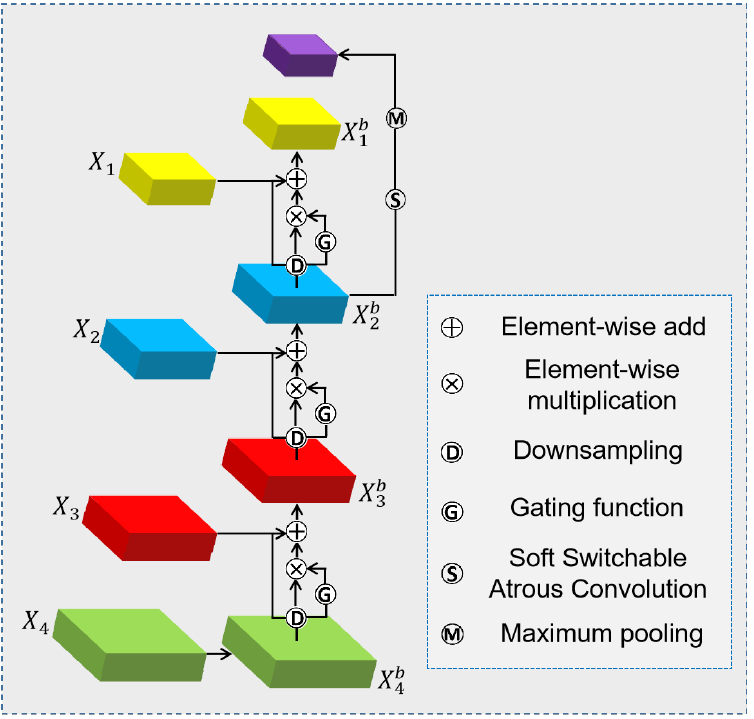
Figure 5. Framework of the bottom-up gating